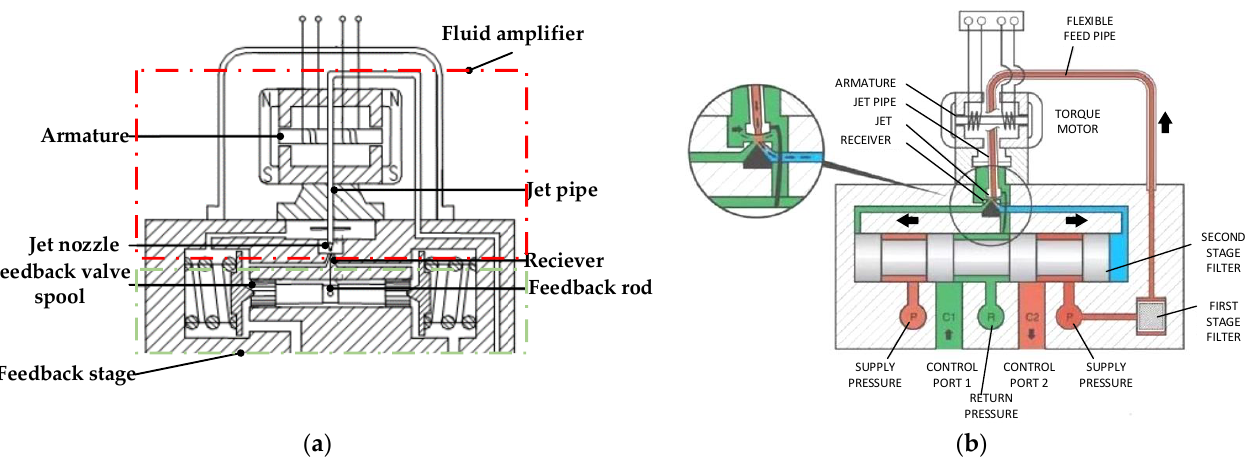
Figure 24. Servo valve force feedback structure: ( a ) Pressure servo valve pre-stage, ( b ) Jet pipe force feedback two-stage hydraulic servo valve.